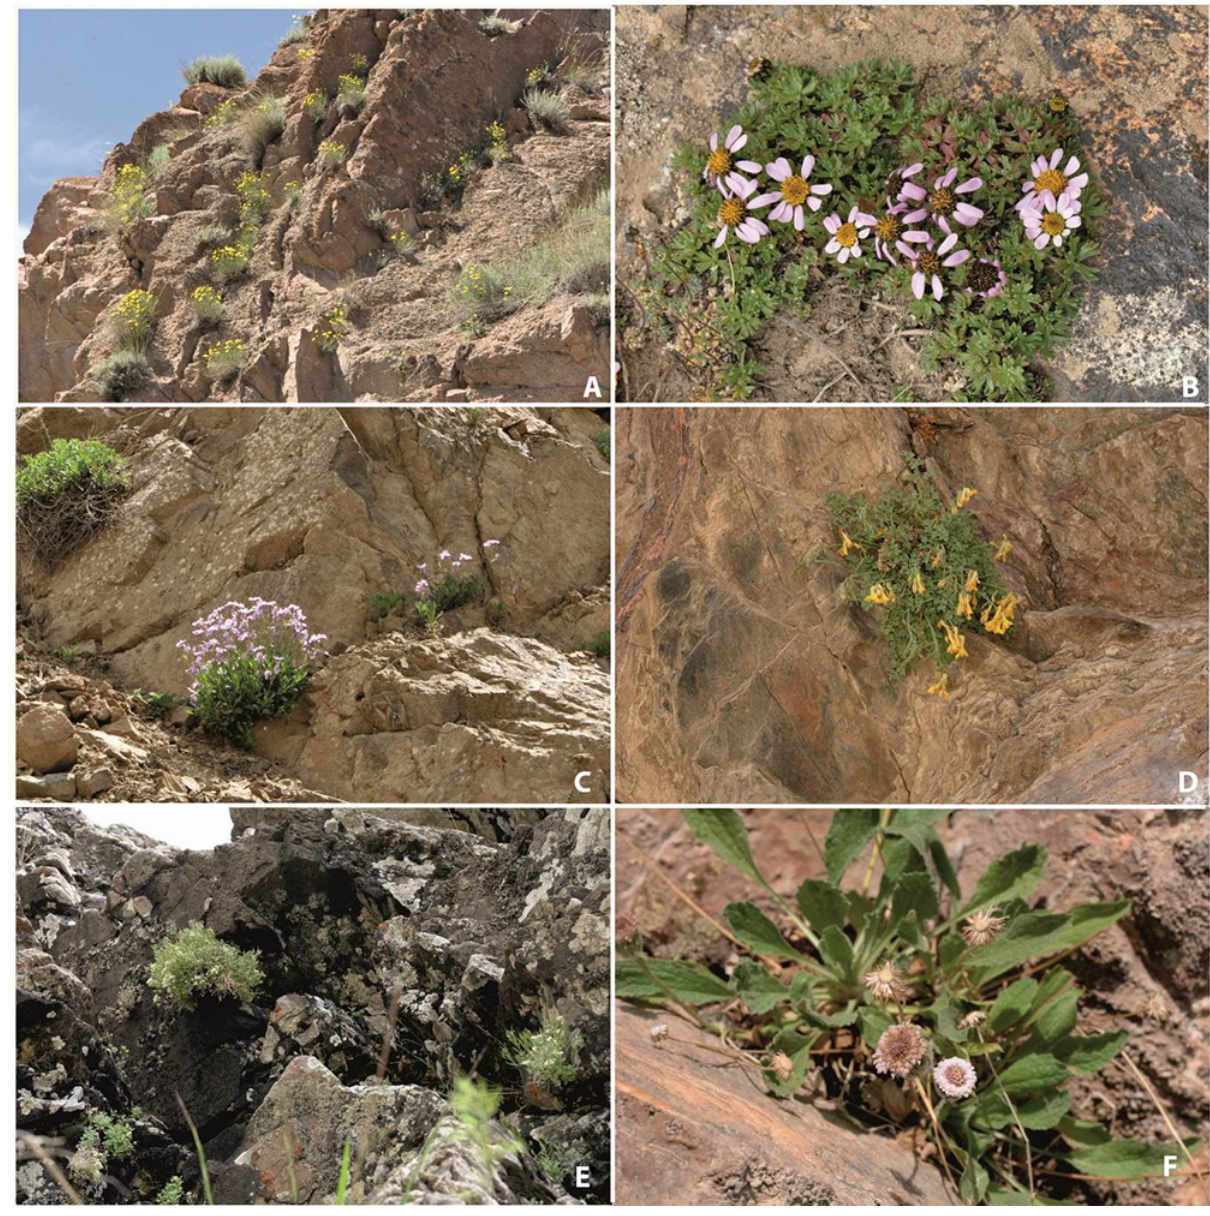
Figure 5 Photographs of the chasmophytic vegetation belonging to the: ( A ) Crepidifolio tenuifolii-Stipetum tianschanicae in the North Alichurian Range in the Eastern Pamir, ( B ) community of Potentilla malacotricha and Waldheimia glabra in the rock outcrops to the north of Jelondy, ( C ) Parryetum schugnanae on the limestone rocks near Jelondy, ( D ) Corydalideto bucharicae-Hippolytietum schugnanicae on the solid limestone rock faces in the Khuf River Valley in the Western Pamir, ( E ) Drabetum darvasicae on the limestone rock ledges close to Khoburobod Pass in Darvaz Range, ( F ) Psychrogetonetum andryaloidetis in the limestone rock cles in the Obikhingou River valley close to Tavildara. All pictures were taken by A. Nowak. ActaSocietatisBotanicorumPoloniae / 2022 / Volume 91 / Article 911 Publisher: Polish Botanical